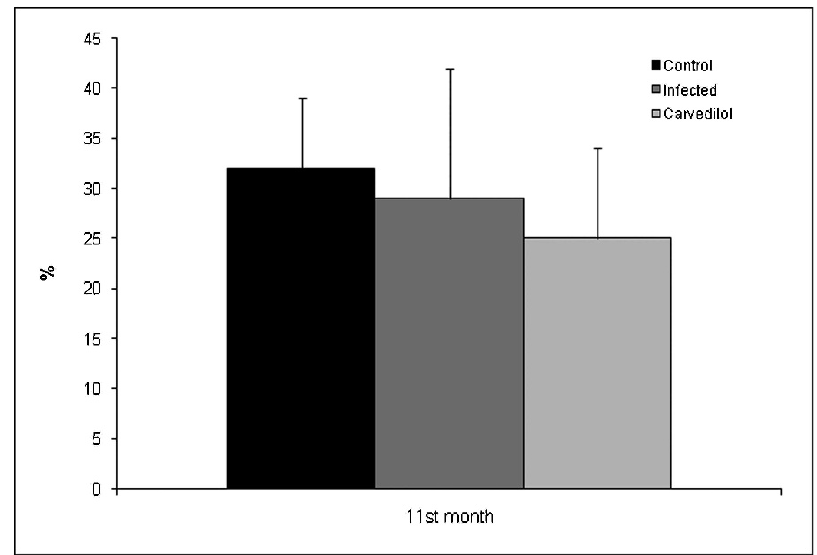
Figure 4 - Fractional shortening at 11 months, with no significant differences ( p